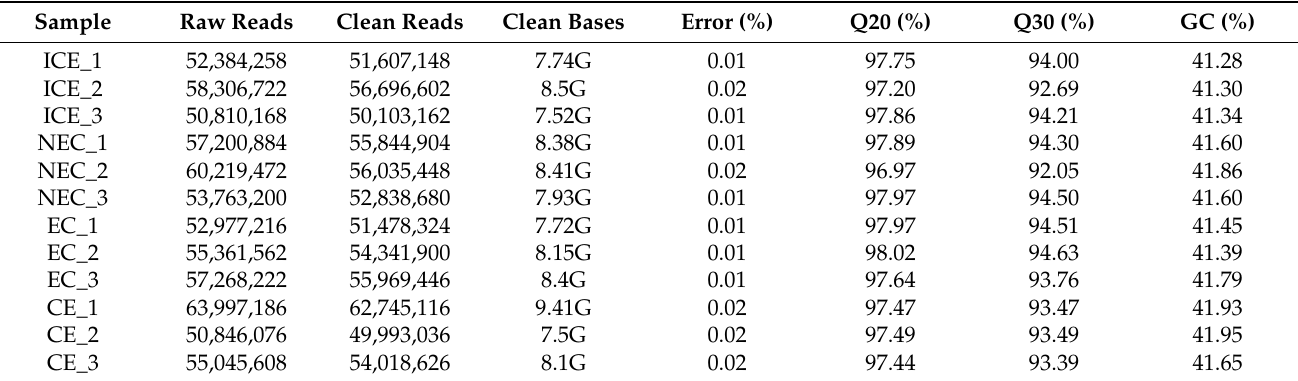
Table 1. Transcriptome data quality